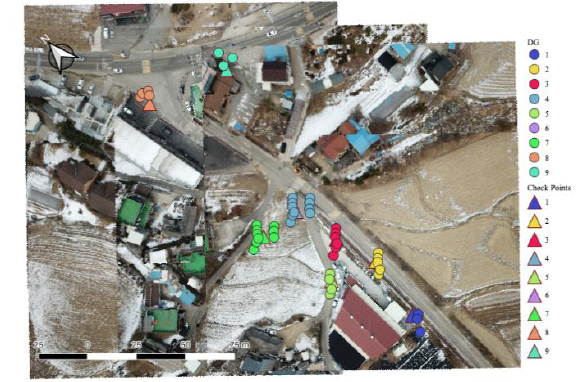
Figure 6. Check points and corresponding image points (DG)